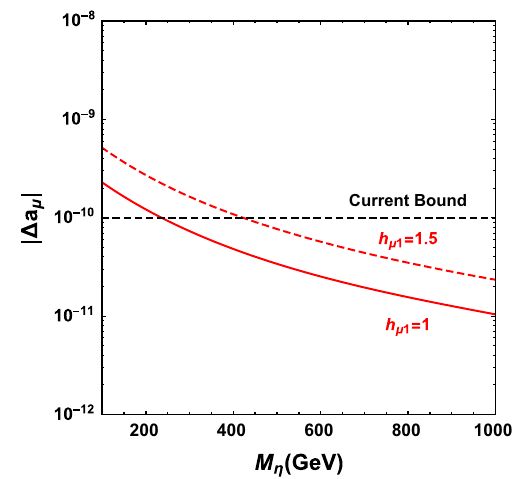
Fig. 5 Predicted relic density as a function of m η , where we have fix = 200 = 200 GeV. The green line corresponds to the observed relic 1 M N 1 density (cid:18) h 2 = 0 . 120 ± 0 . 001